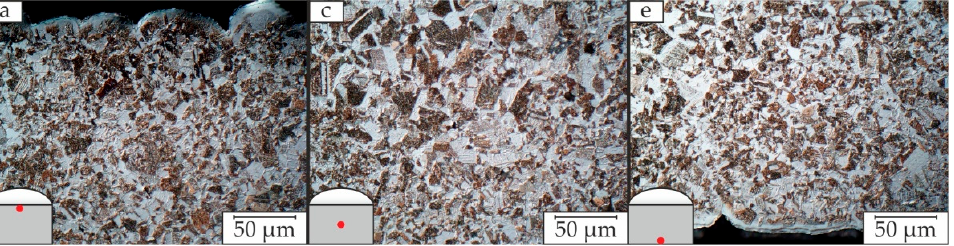
Figure A2. Microstructure in defined positions a, c and e according to Figure 1 (right) of a GE48 sample sintered at 1250 °C, with 2 min dwell time and 30 MPa pressure.